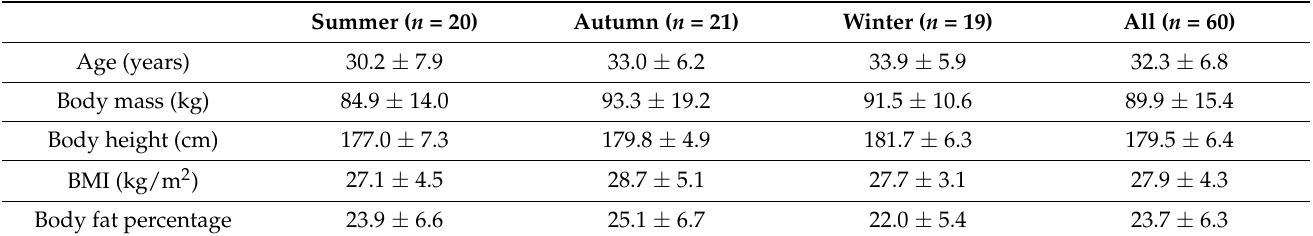
Table 2. The characteristics of the study